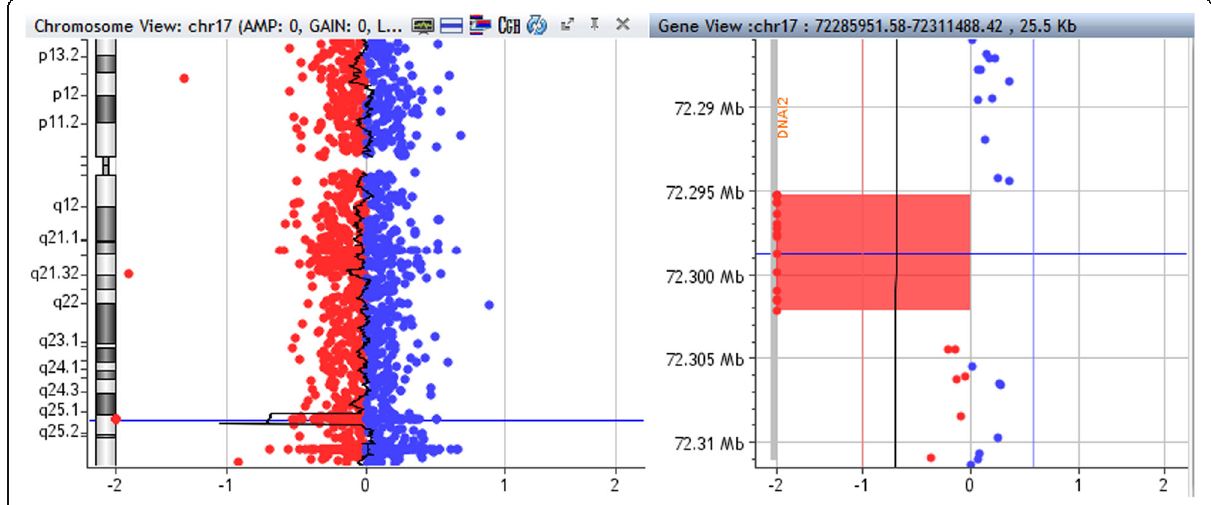
Fig. 2 Chromosome 17 array profile (left); highlight of the homozygous deleted region, involving the DNAI2 gene